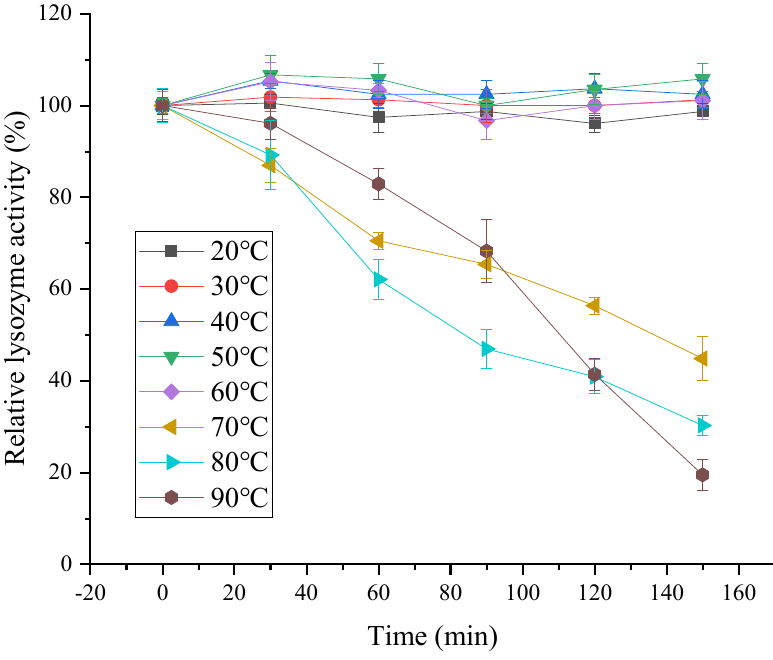
Figure 10. Temperature stability of lysozyme from SDEW.